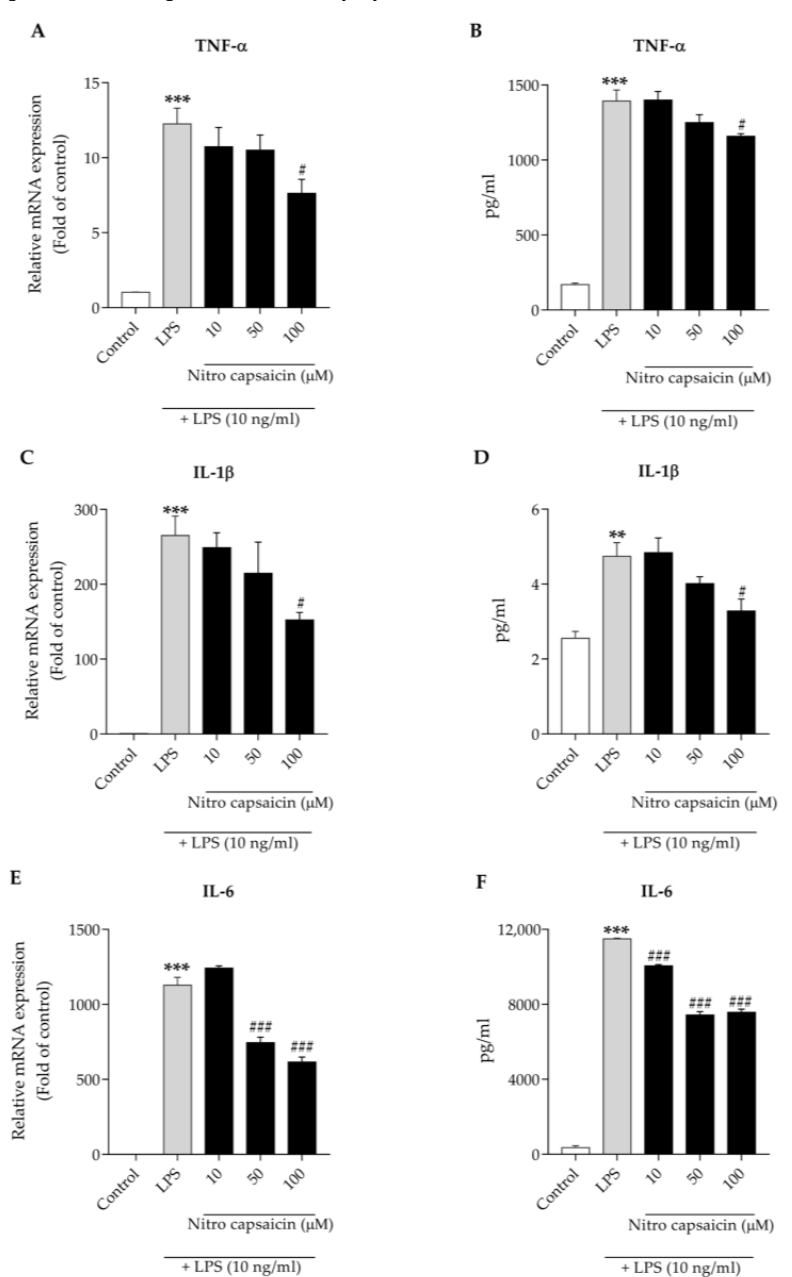
Figure 3. Effects of nitro capsaicin against LPS-induced proinflammatory cytokine production in SIMA9 cells. Nitro capsaicin decreased mRNA expression of ( A ) TNF- α , ( C ) IL-1 β , and ( E ) IL-6. Nitro capsaicin reduced release of the cytokines ( B ) TNF- α , ( D ) IL-1 β , and ( F ) IL-6. The control was DMSO treatment. ** p < 0.01 and *** p < 0.001 versus control group; # p < 0.05 and ### p < 0.001 versus LPS-treated group.